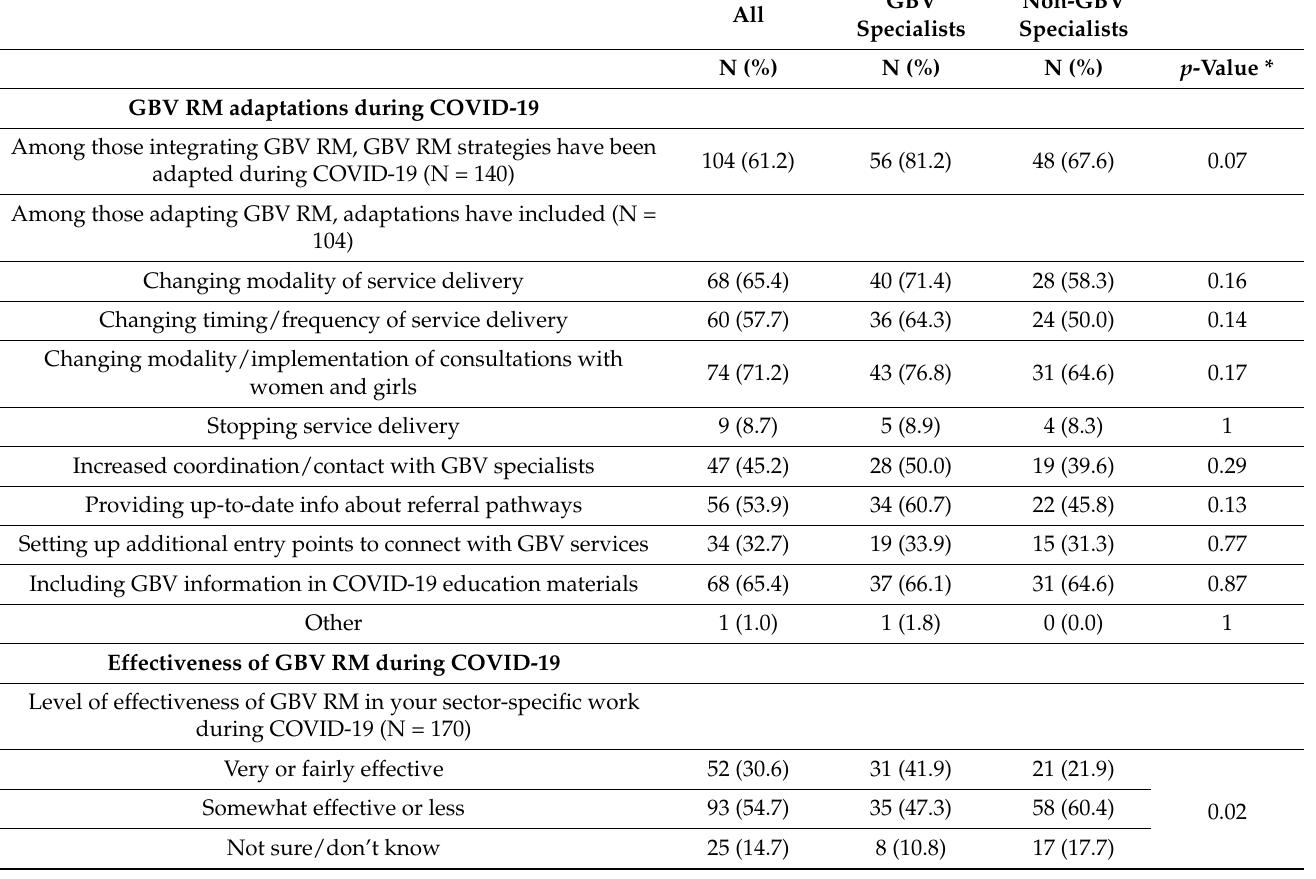
Table 6. GV risk mitigation adaptations and effectiveness during COVID-19.